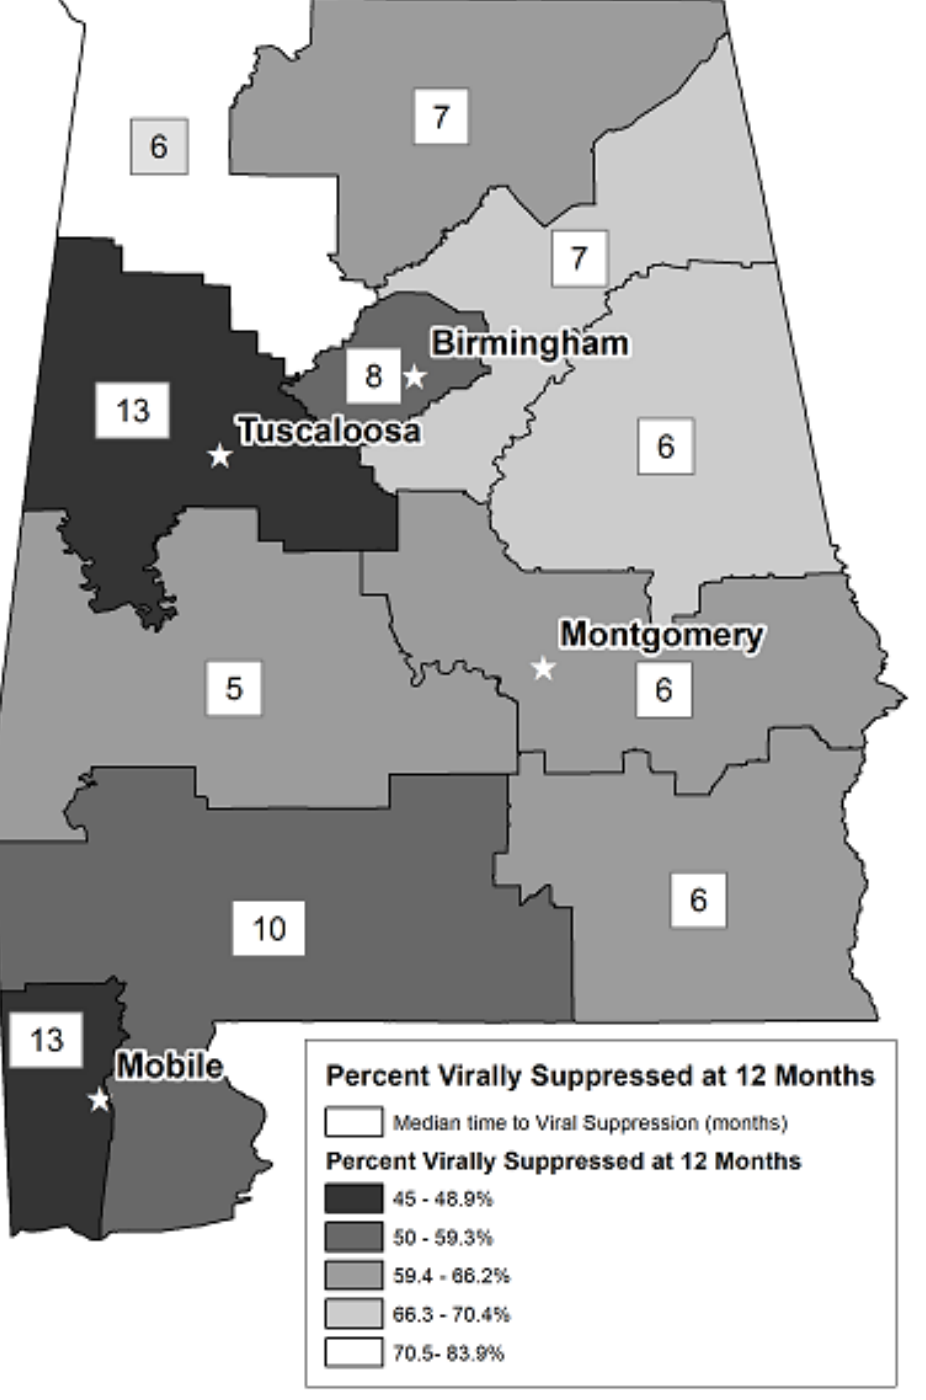
Figure 1. Viral suppression (<200 c/mL) within 12 months of HIV diagnosis and median time to suppression among 1,979 persons with newly diagnosed HIV in Alabama, by Alabama Public Health Area (PHA),